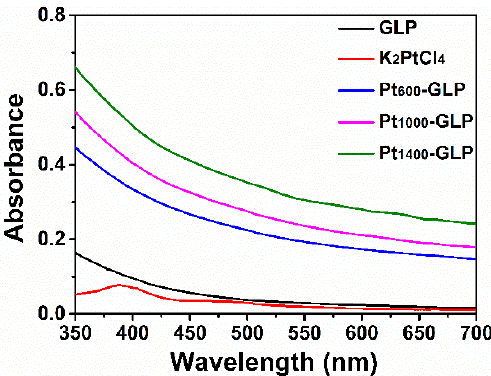
Figure 3. UV-Vis spectra of GLP, K 2 PtCl 4 , and Pt n -GLP NCs (n = 600, 1000, and 1400). Metal nanoparticles exhibit unique physical and chemical properties due to their small size and large specific surface area. In general, smaller particles show better catalytic efficiency, because smaller nanoparticles possess a larger surface-to-volume ratio [28]. Here, the size of Pt NCs inside Pt 600 -GLP NCs was measured by HRTEM. As shown in Figure 4, the Pt NCs inside Pt 600 -GLP NCs existed in a good monodisperse state, and the calculated average diameter of Pt NCs inside Pt 600 -GLP NCs was 1.44 ± 0.34 nm. Supplementary Materials Figure S1 showed that the Pt NCs inside Pt 600 -GLP NCs and Pt 1000 -GLP NCs had a good dispersion state, respectively. The size of Pt NCs inside Pt 1000 -GLP NCs and Pt 1400 -GLP NCs were 2.12 ± 0.72 nm and 2.34 ± 0.54 nm, respectively. These results indicated that Pt NCs inside Pt n -GLP NCs had a small size within 1–3 nm and narrow size distribution, which may be contributed by the mild reducing ability of GLP [29]. The specific surface area of the nanoparticles was calculated by the surface area and volume method, and the specific surface area was 4.41 ± 1.46 nm 2 /nm 3 for Pt 600 -GLP NCs, 3.20 ± 1.54 nm 2 /nm 3 for Pt 1000 -GLP NCs, and 2.59 ± 0.71 nm 2 /nm 3 for Pt 1400 -GLP NCs. Thus, Pt 600 -GLP NCs had the largest specific surface area, and they were used for subsequent experiments.